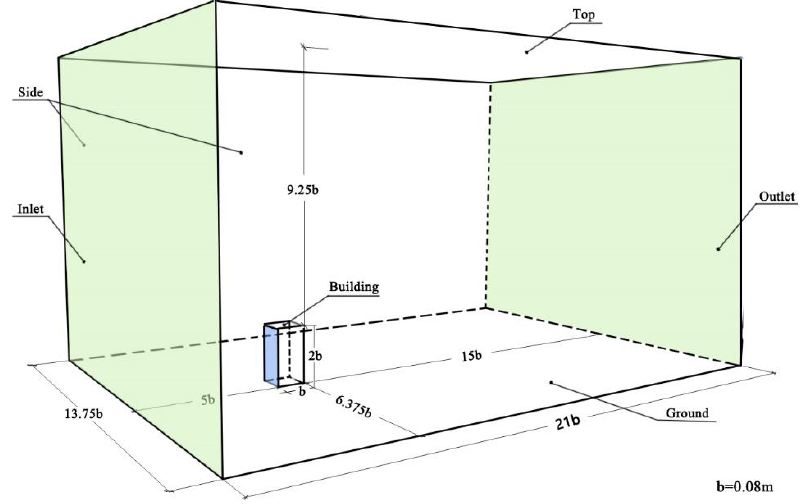
Figure 2. High-rise building and computational domain.